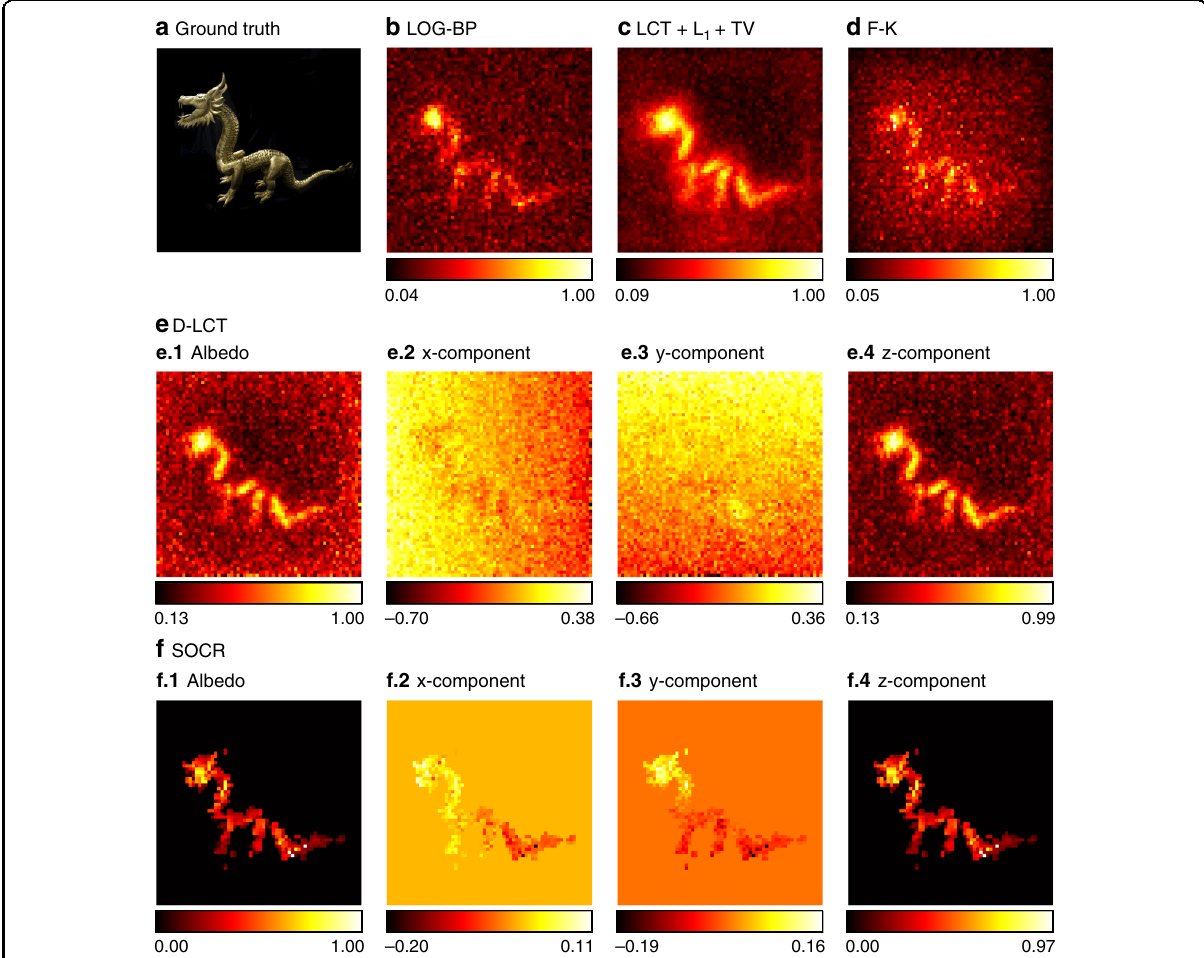
Fig. 10 Reconstruction results of the dragon (confocal, 15 s). The ground truth is shown in a . Reconstructions are shown in b – f . Reconstruction results of the LOG-BP, F-K, and D-LCT methods are noisy. The LCT + L 1 + TV reconstruction contains smooth background noise. The x -component and y -component of the D-LCT method are corrupted with noise. The proposed framework provides a faithful reconstruction of the target with little